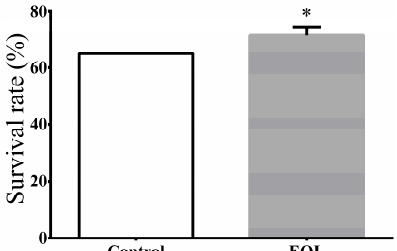
Figure 4. The survival rate of C. elegans under thermal stress. Differences were considered significant at p < 0.05 (*).